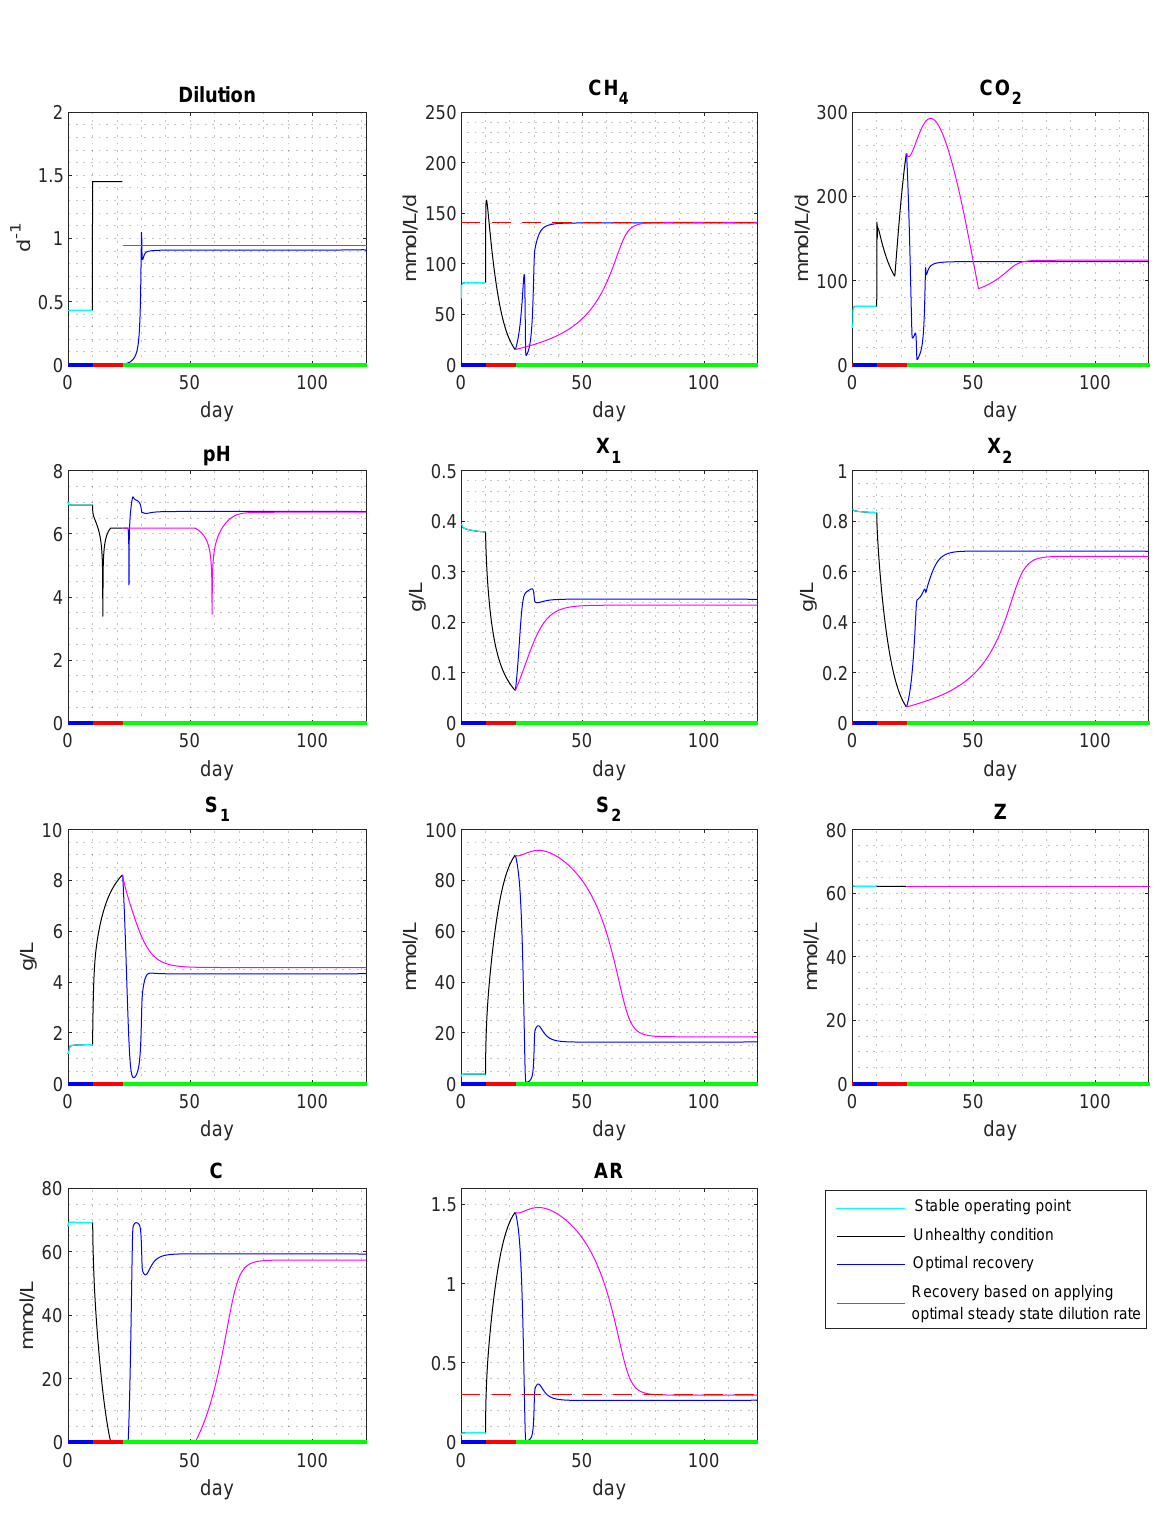
Figure 3: Optimal recovery of methane production based on methane production threshold of 15 mmol/L/d. Along the time axis, the blue band represents stable operation conditions. The red band represents unhealthy conditions, and the green band is the recovery